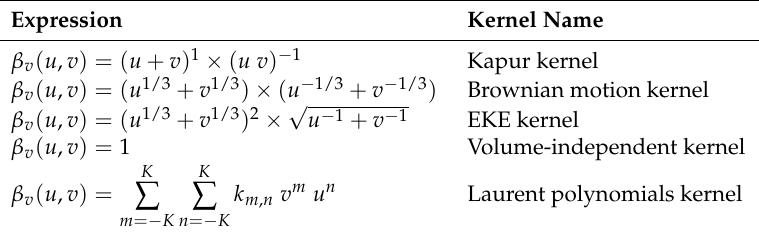
Table 2. Kernel model candidates used for parameter